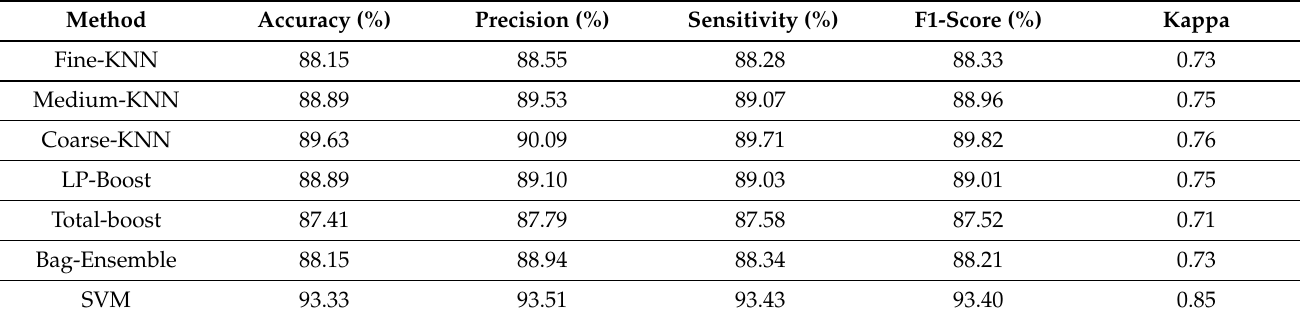
Table 9. Results obtained using different ML classifiers on 70–30